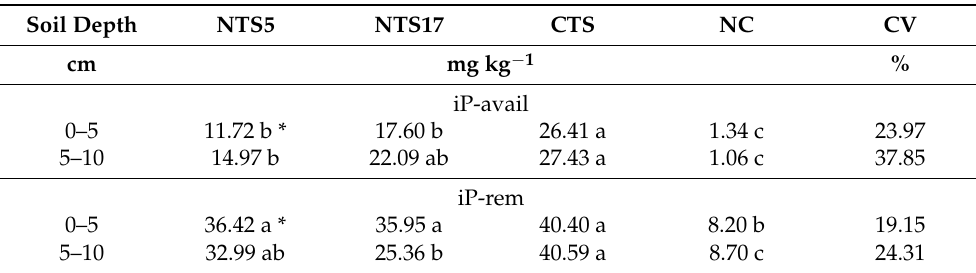
Table 3. Inorganic P (iP) available (iP-avail) and remaining (iP-rem) obtained in routine analyses of different